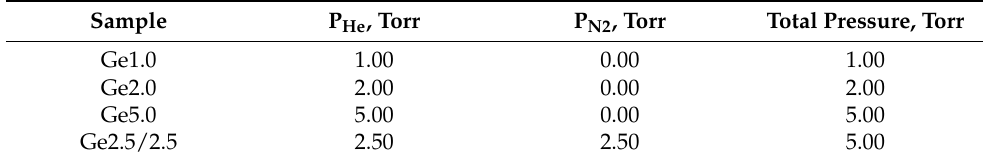
Table 1. Samples of Ge nanocrystalline films prepared by